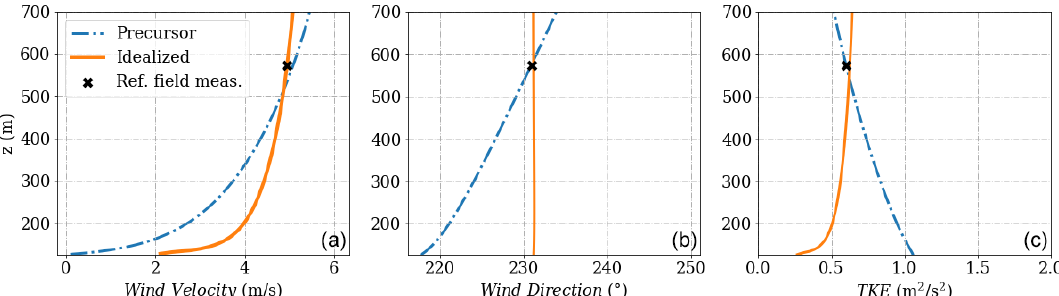
Figure A4. Idealized and precursor (developed) input profiles for (a) wind velocity magnitude, (b) wind direction and (c) turbulent kinetic energy tuned to reach calibration at height 573m corresponding to 100m at Tower 20 (tse04).